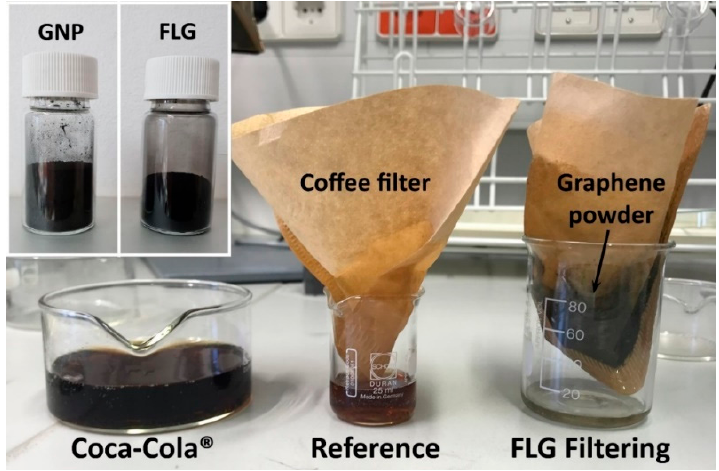
Figure 1. Difference in the volume occupied by 2 g of GNP and FLG powders (upper left); filtration setup for water purification showing a coffee filter filled with graphene powder (right), an empty coffee filter used for reference (middle) and the pure Coca-Cola ® (left).